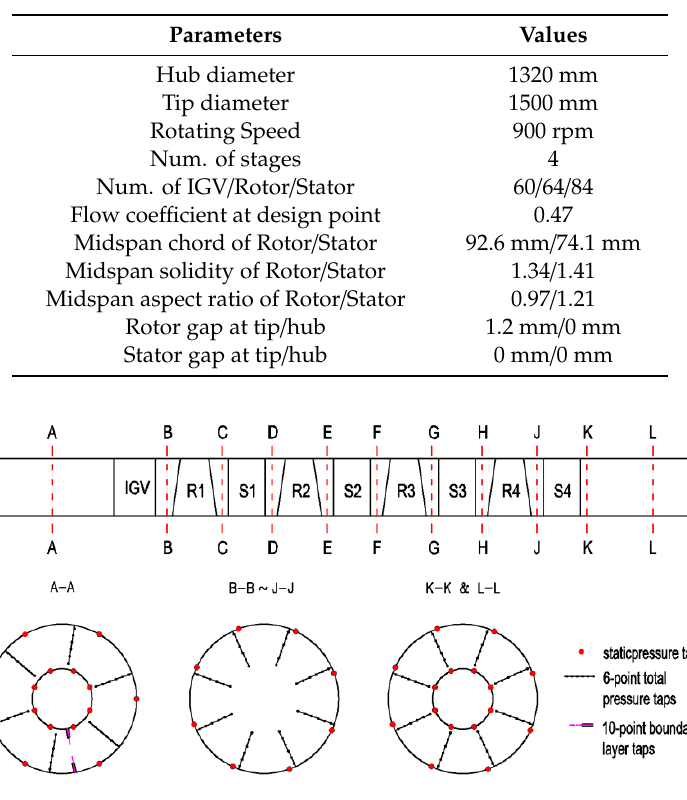
Figure 2. Test configurations of the compressor rig.